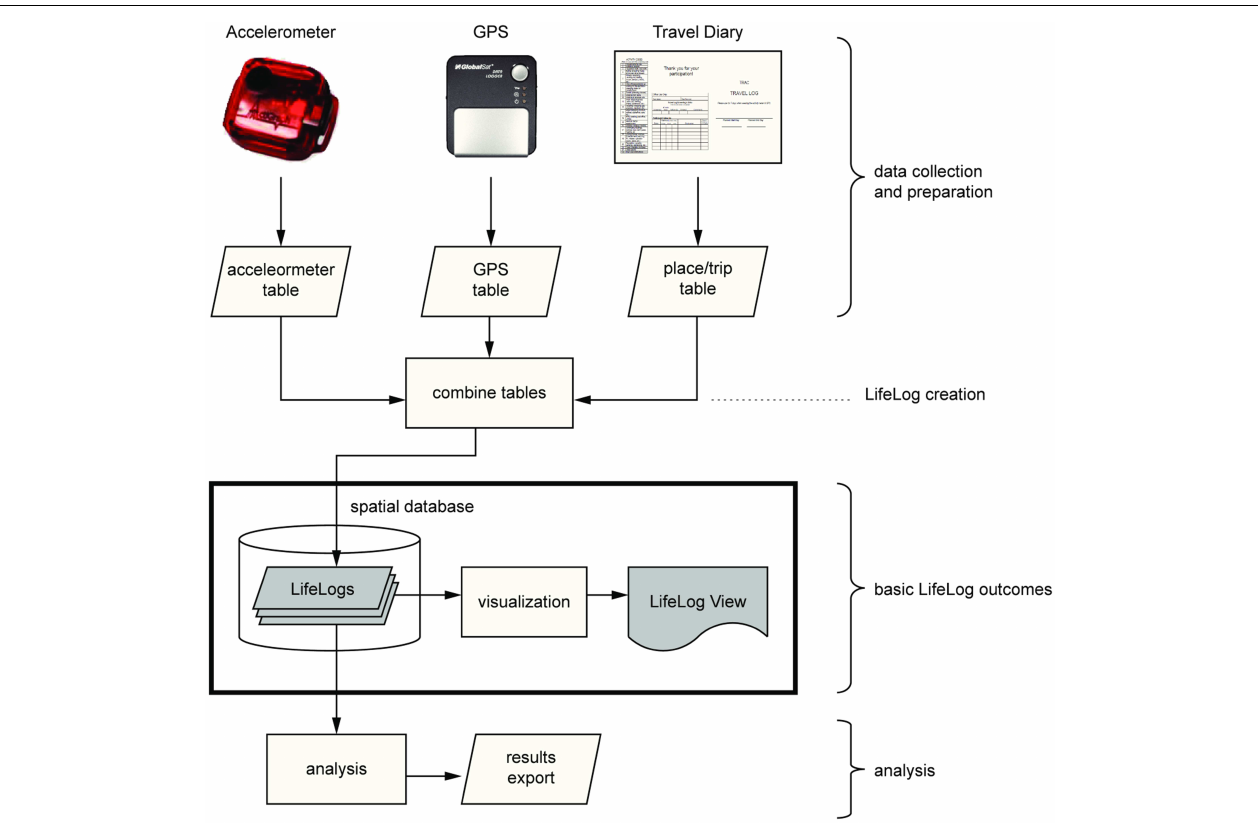
FIGURE 8 | Illustration of LifeLog work flow